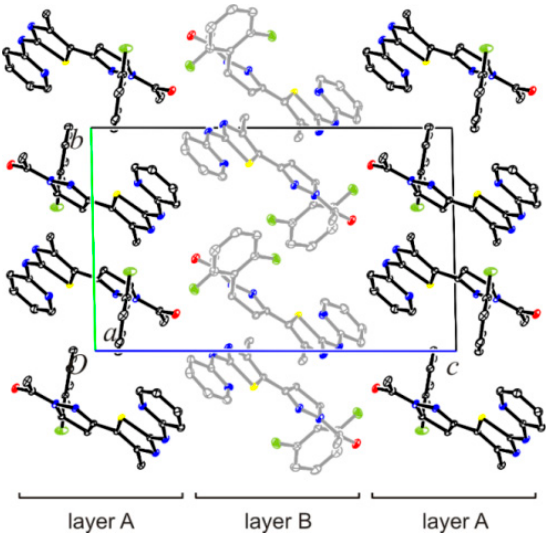
Figure 7. ORTEP view of the molecular packing in the crystal structure of compound 6 .